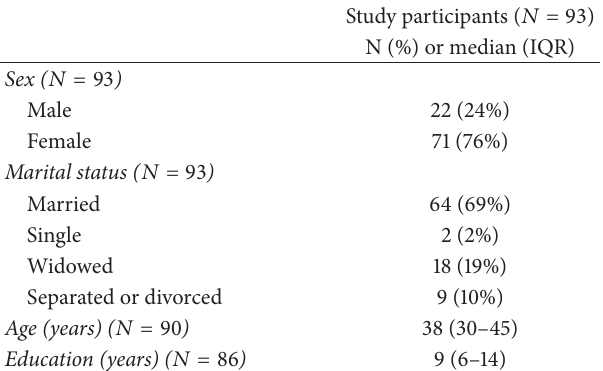
Table 1: Personal information on study patient